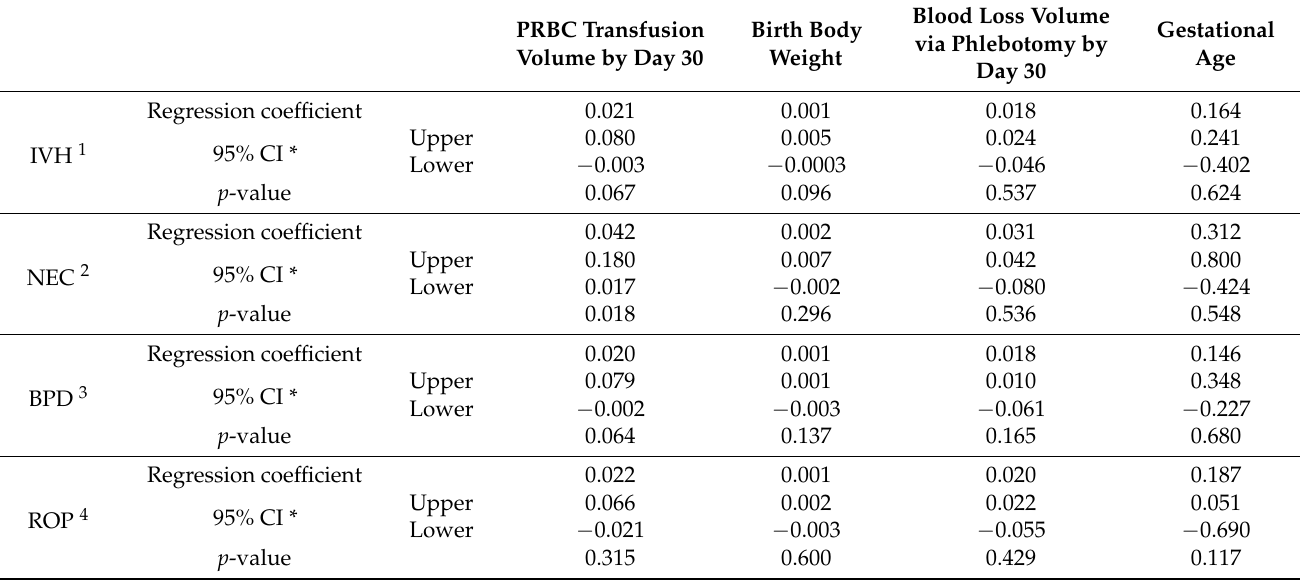
Table 6. Multiple regression analysis of factors for complications related to oxidative